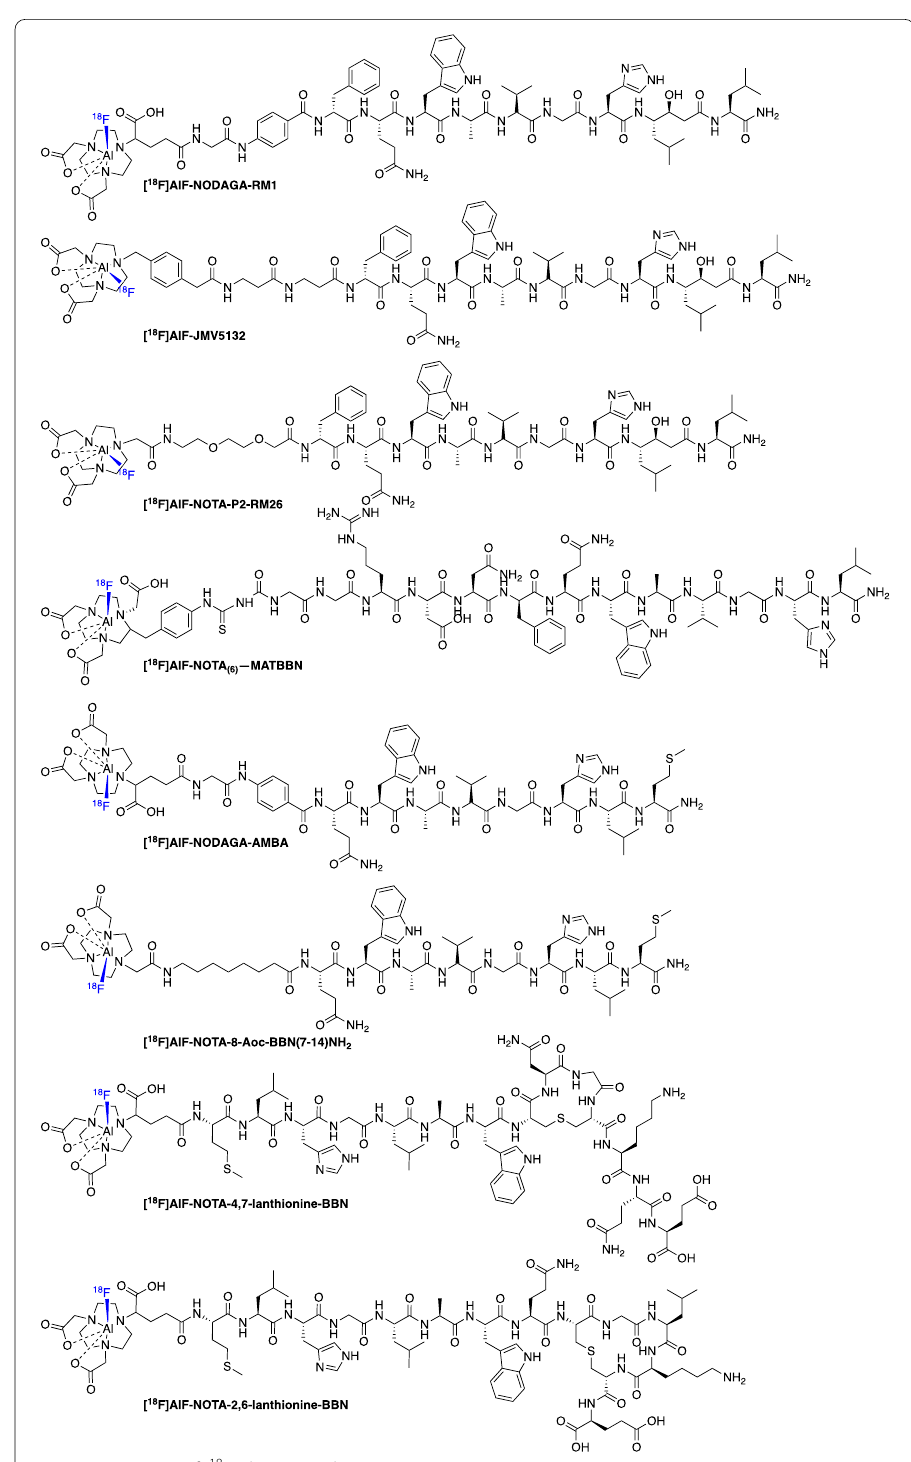
Fig. 10 Structures of [ 18 F]AlF BBN analogs targeting